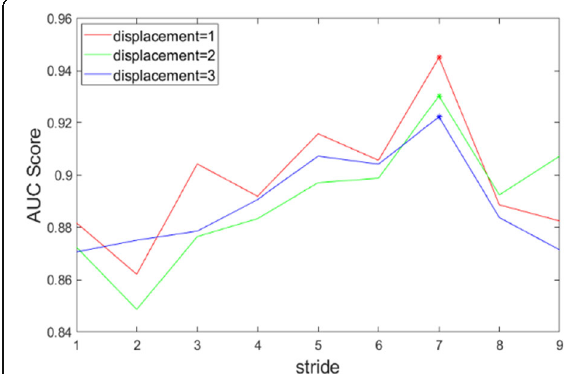
Fig. 7 AUC score trends with the stride increasing for LMD + LMS. “ * ” indicates the best result position of each curve. AUC: Area under the curve of receiver operating characteristic curve; LMS: Learning model by multiple strides; LMD: Learning model by multiple displacements